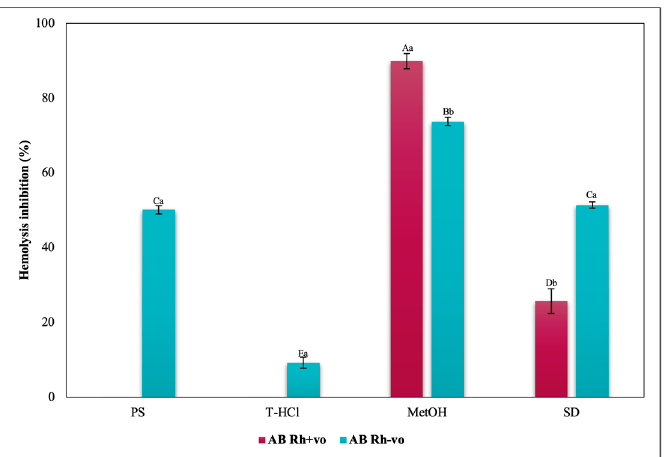
Figure 20. Inhibitory effect of heat-induced hemolysis of P. cruentum extracts on human erythrocytes with different RhD (positive and negative) of AB blood group. Different letters represent significant differences in the means between treatments and groups ( p ≤ 0.001). Capital letters represent a two- way ANOVA. Lowercase letters represent a univariate ANOVA between the extracts. PS, extract of physiological solution; T-HCl, 0.5 M Tris-HCl extract; MetOH, 99% methanol extract; SD, sodium diclofenac.